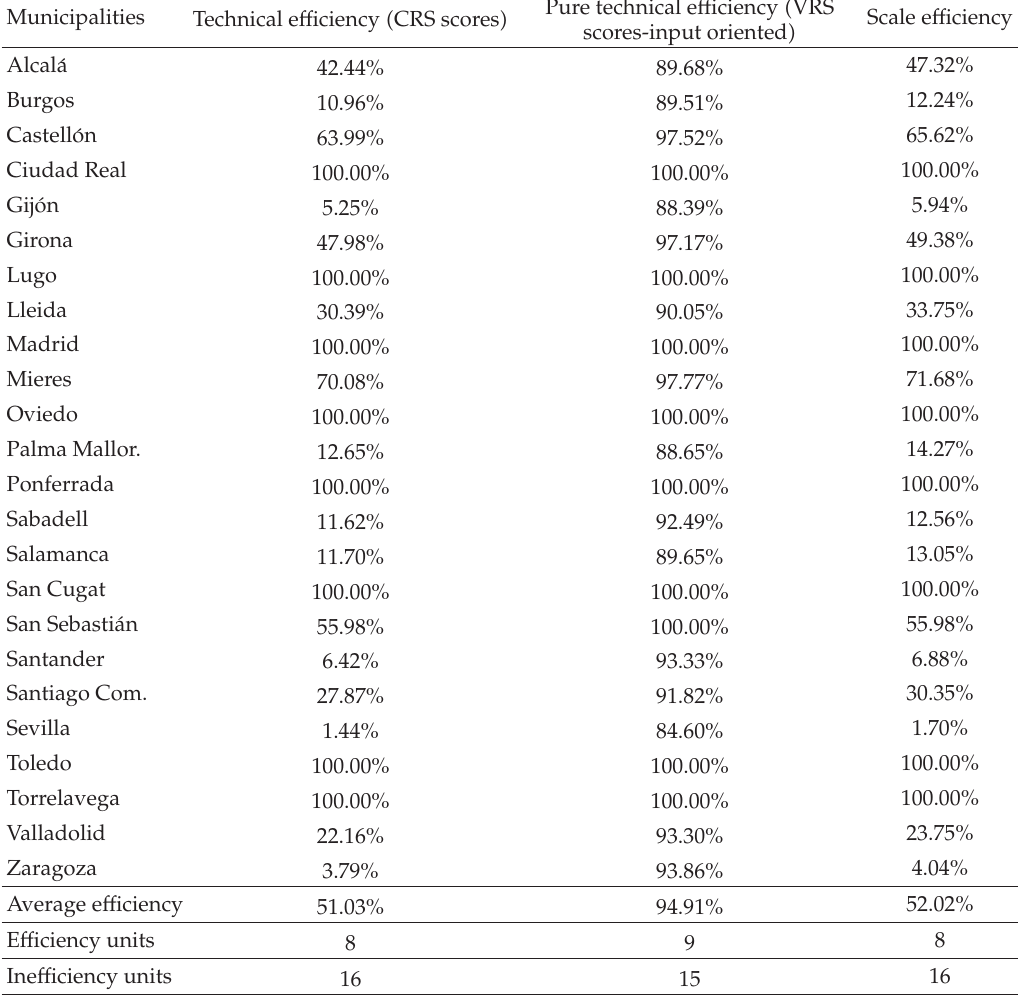
Table 7: CCR- and BCC-e ffi ciency index for Spanish public bus